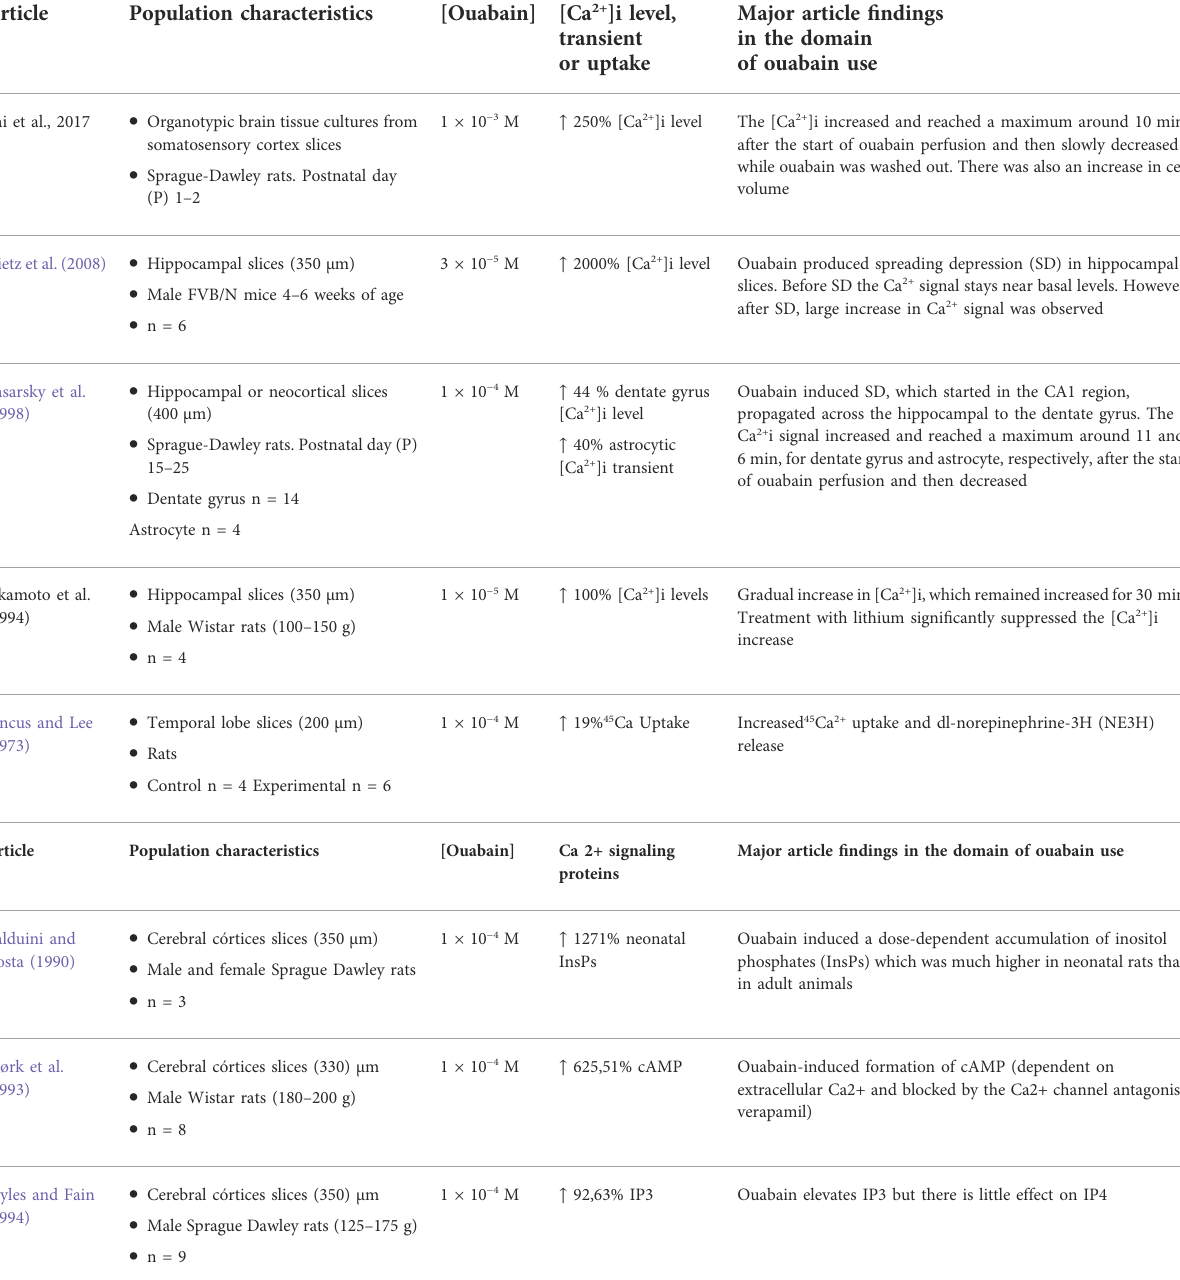
TABLE 3 Summary of brain slices